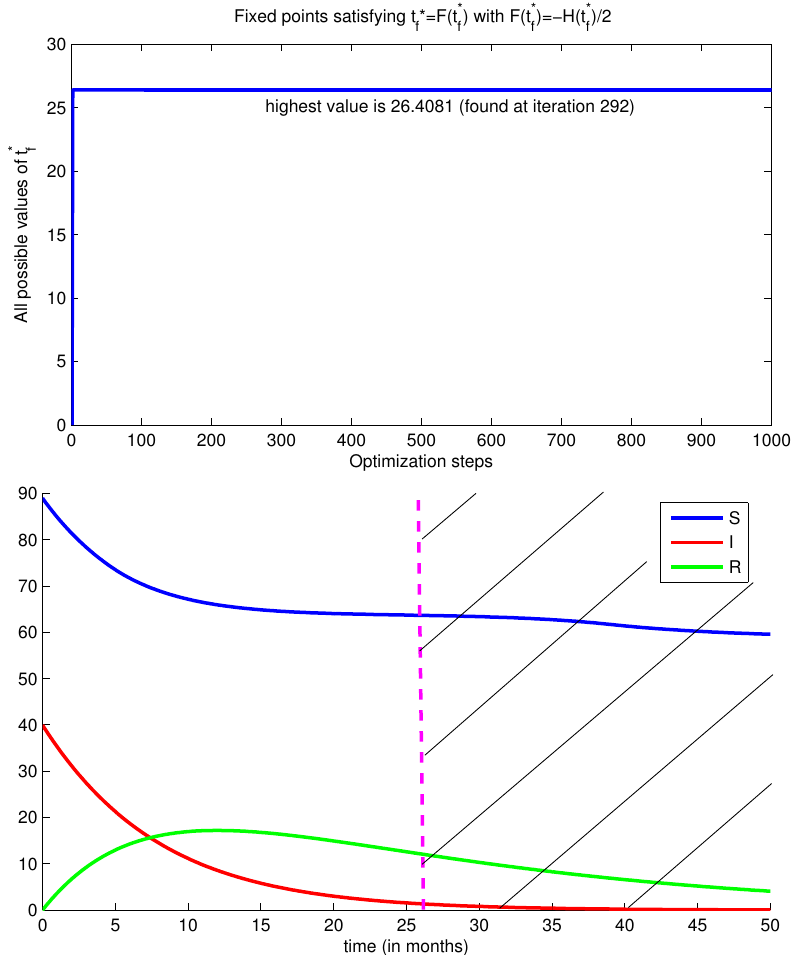
Figure 2. SIR dynamics with the precision of the optimal horizon t ∗ conditions and severity weights constants as in Figure